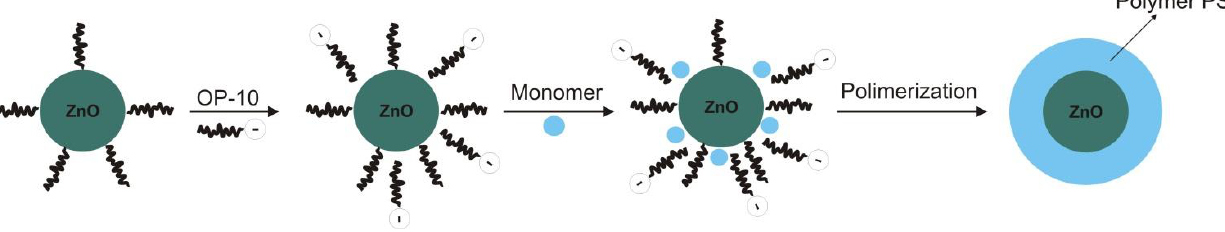
Figure 9. Mechanism of nano-ZnO/PS composite synthesis by in situ emulsion polymerization (created based on [109] with permission from Elsevier